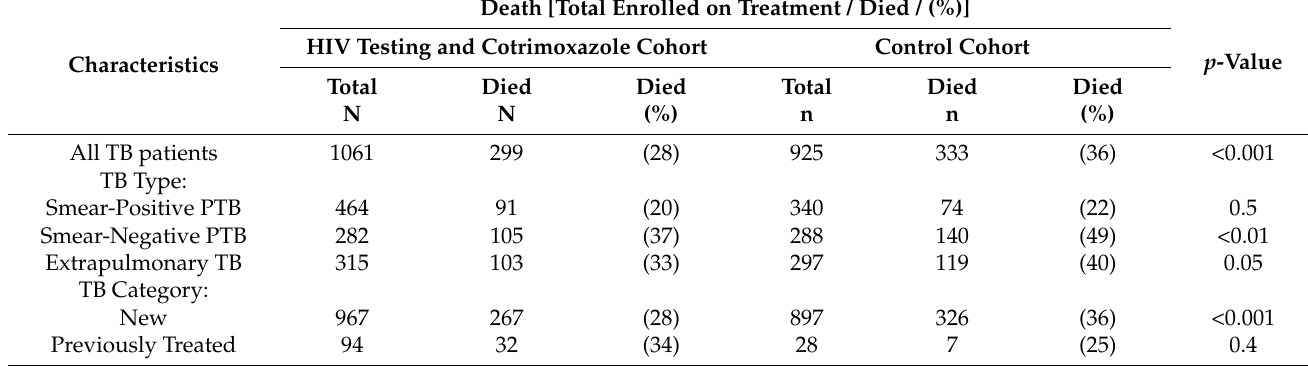
Table 2. Death in TB patients in the intervention (HIV testing and cotrimoxazole) and control groups, Thyolo District,